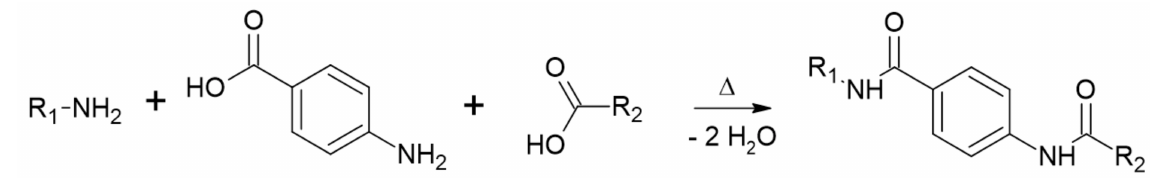
Figure 15. Potential condensation reaction of p-aminobenzoic acid and terminal amino and carboxyl groups of polymeric residues for the formation of secondary